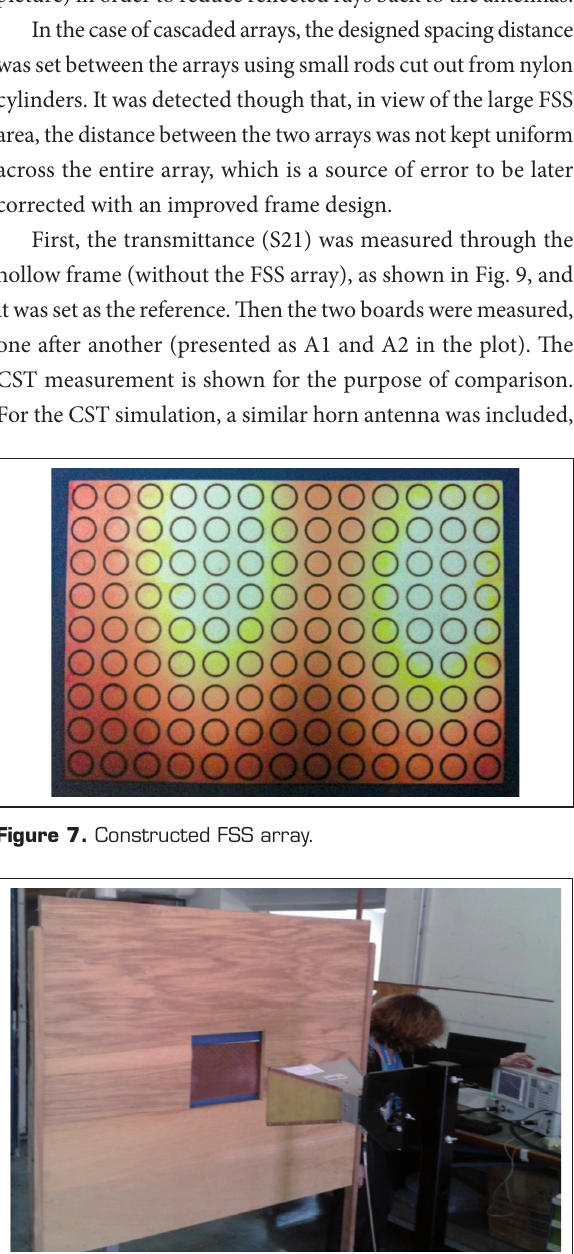
Figure 8. Measurement